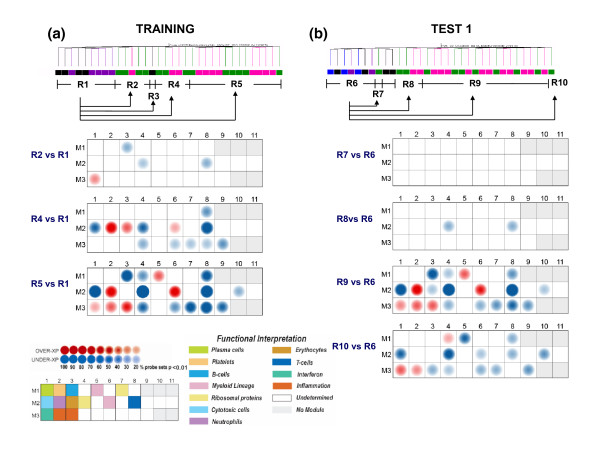
Modular transcriptional fingerprints for regions defined by unsupervised condition clustering. A modular analysis framework was used to generate modular transcriptional fingerprints for the major regions identified in Figure 2. Significant differences in expression levels in comparison to a baseline sample are indicated by a spot, with the intensity of the spot representing the proportion of significantly differentially expressed transcripts for each one of the transcriptional modules. The color of the spot indicates the direction of change of expression: red = overexpressed, blue = underexpressed. For the training set, region R1 was used as the baseline for all comparisons, while for the first test set region R6 was used as the baseline. Functional interpretations are indicated by the color coded grid at the bottom left of the figure.